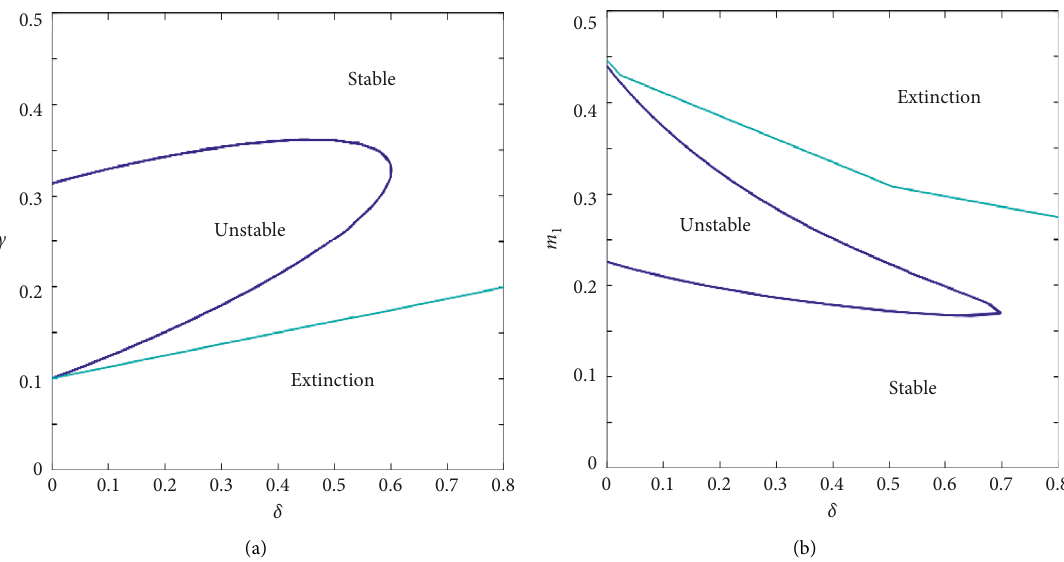
Figure 7: (a) The two-parameter bifurcation diagram of the model (51) with m � 0 . 2, c ∈ ( 0 , 0 . 5 ) , and δ ∈ ( 0 , 0 . 8 ) . (b) The two-parameter 1 bifurcation diagram of the model with c � 0 . 34, m ∈ ( 0 , 0 . 5 ) , and δ ∈ ( 0 , 0 . 8 ) . The cyan color line separates the stable and extinction region. 1 The blue color line (Hopf bifurcation curve) separates the stable and unstable